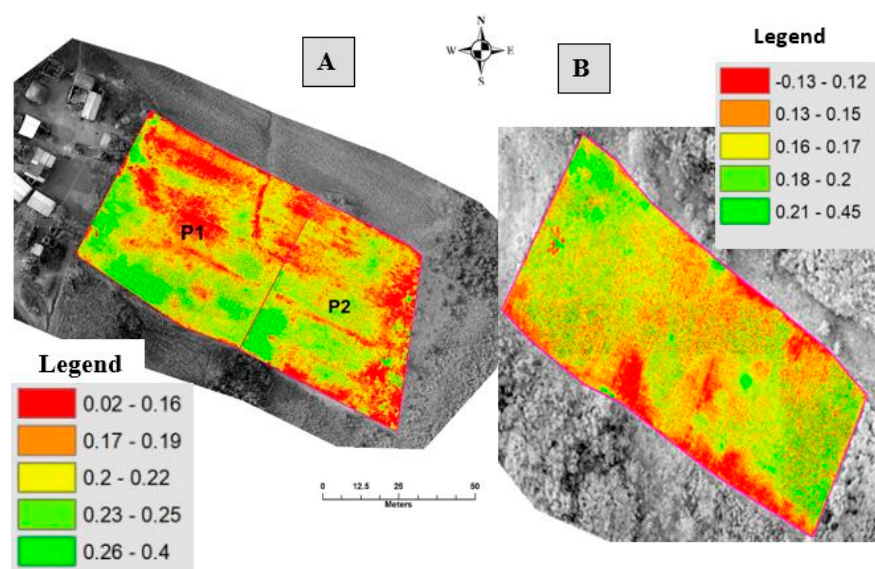
Figure 5. Significant within-plot variability in crop vigour at both study locations. NB: Sample plots A (in Asitey) and B (in Akatawia) were surveyed at 7 and 6 weeks after sowing, respectively. The density and intensity of vegetation present is used to assess vegetation vigour so that the healthier the vegetation, the greener the pixels and vice versa. Thus, the spectrum ranges from 0 to ~0.16 µ m for bare lands / soils, and ~0.17 through ~0.45 µ m for various levels of vegetation vigour. Based on theory and ground-truthing, maize crops typically fall between ~0.20 and ~0.30 µ m (light green pigment) with those above this threshold corresponding to tree canopies and secondary vegetations.